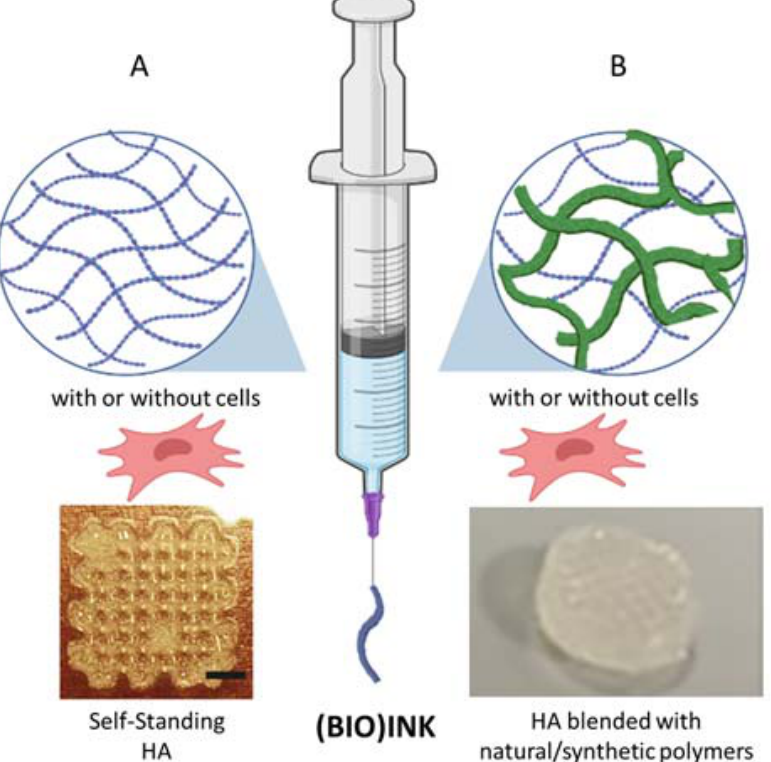
Figure 8. Schematic representation of hyaluronic acid (HA)-based (bio)ink as ( A ) self-standing material and ( B ) blended with other natural/synthetic polymers. Example of 3D printed: ( A ) methac ‐ rylated HA (3 % (w/v)). Adapted with permission from ref. [107]. ( B ) HA (1% (w/v)) blended with alginate (2% (w/v) into a polylactic acid structure. Adapted with permission from [108].